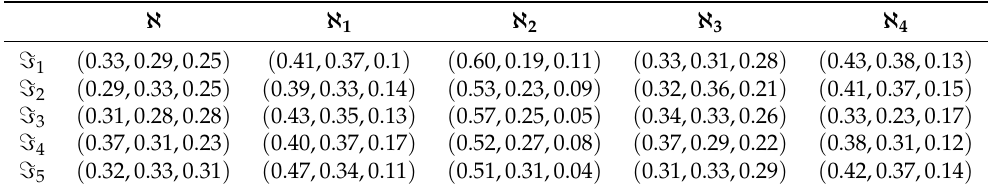
Table 4. Given data in the form of FOFNs.